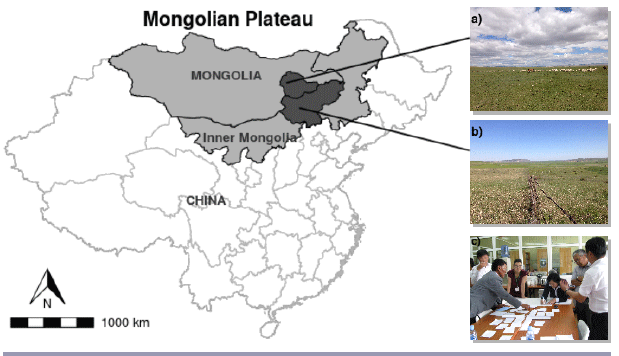
Fig. 1 . Location of the Mongolian Plateau, which includes the country of Mongolia and the Inner Mongolia Autonomous Region of China. The two case study regions from the systems dynamic modeling highlighted in dark grey (a) Sukhbaatar Aimag, Mongolia and (b) Xilingol League, Inner Mongolia; and (c) photo of participants from the 2014 Scenario Planning Workshop in